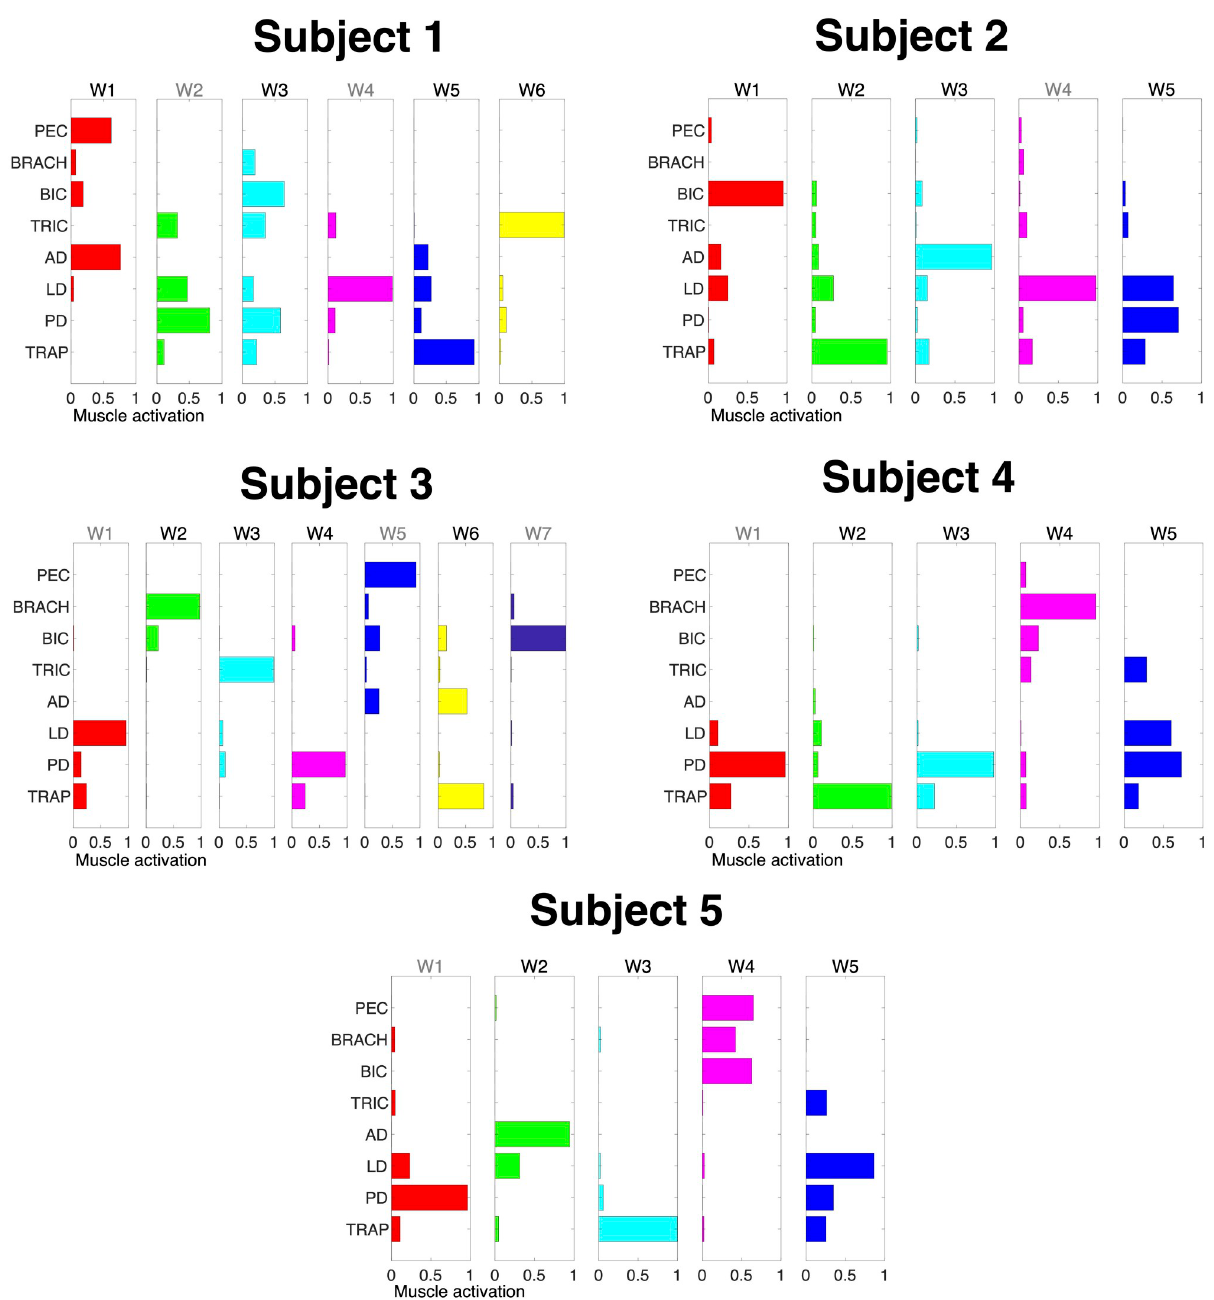
Fig 3. Muscle synergies. Muscle synergies (matrix W) identified by non-negative matrix factorization from the EMG data of each participant (columns) collected in the force-control block. Each column of W is a vector specifying a specific pattern of relative level of muscle activation. Synergies in black represent the ones selected for use in the 2-D myocontrol task for the Select Synergy condition. Pectoralis major (PEC), brachioradialis (BRACH), biceps (BIC), triceps (TRIC), anterior deltoid (AD), lateral deltoid (LD), posterior deltoid (PD), and middle trapezius (TRAP). W n in black represent the synergies selected after assessment with the 1-D